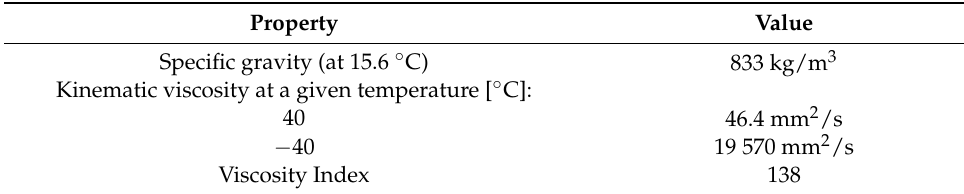
Table 2. Properties of polyalphaolefin 8 (PAO